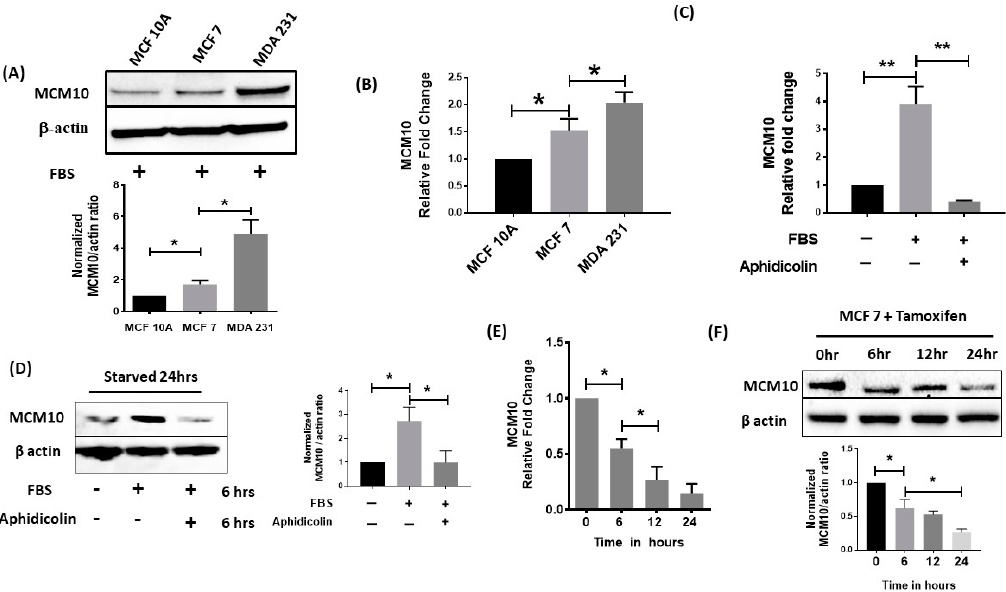
Figure 4. Relative expression of MCM10 in different cells in vitro. ( A , B ) relative protein quantification by Western blots and qPCR for the normal breast epithelial cell line MCF10A and for the breast cancer cell lines MCF 7 and MDA 231. High expression of MCM10 was found in MDA 231 cells, which are the most aggressive cells. ( n = 3, * p < 0.05) ( C , D ) expression of MCM10 under stress induced by Fetal bovine serum (FBS) starvation in MDA231 cells. Starved MDA 231 cells showed an increase in MCM10 protein level after six hours in FBS. Interestingly, addition of proliferation inhibitor Aphidicolin further blocked expression of MCM10 observed by Western blots as well as qPCR. ( n = 3, ** p < 0.01) ( E , F ) Tamoxifen treatment to MCF 7 cells reduced MCM10 expression in a time dependent manner observed by qPCR and Western blots. ( n = 3, * p < 0.05).